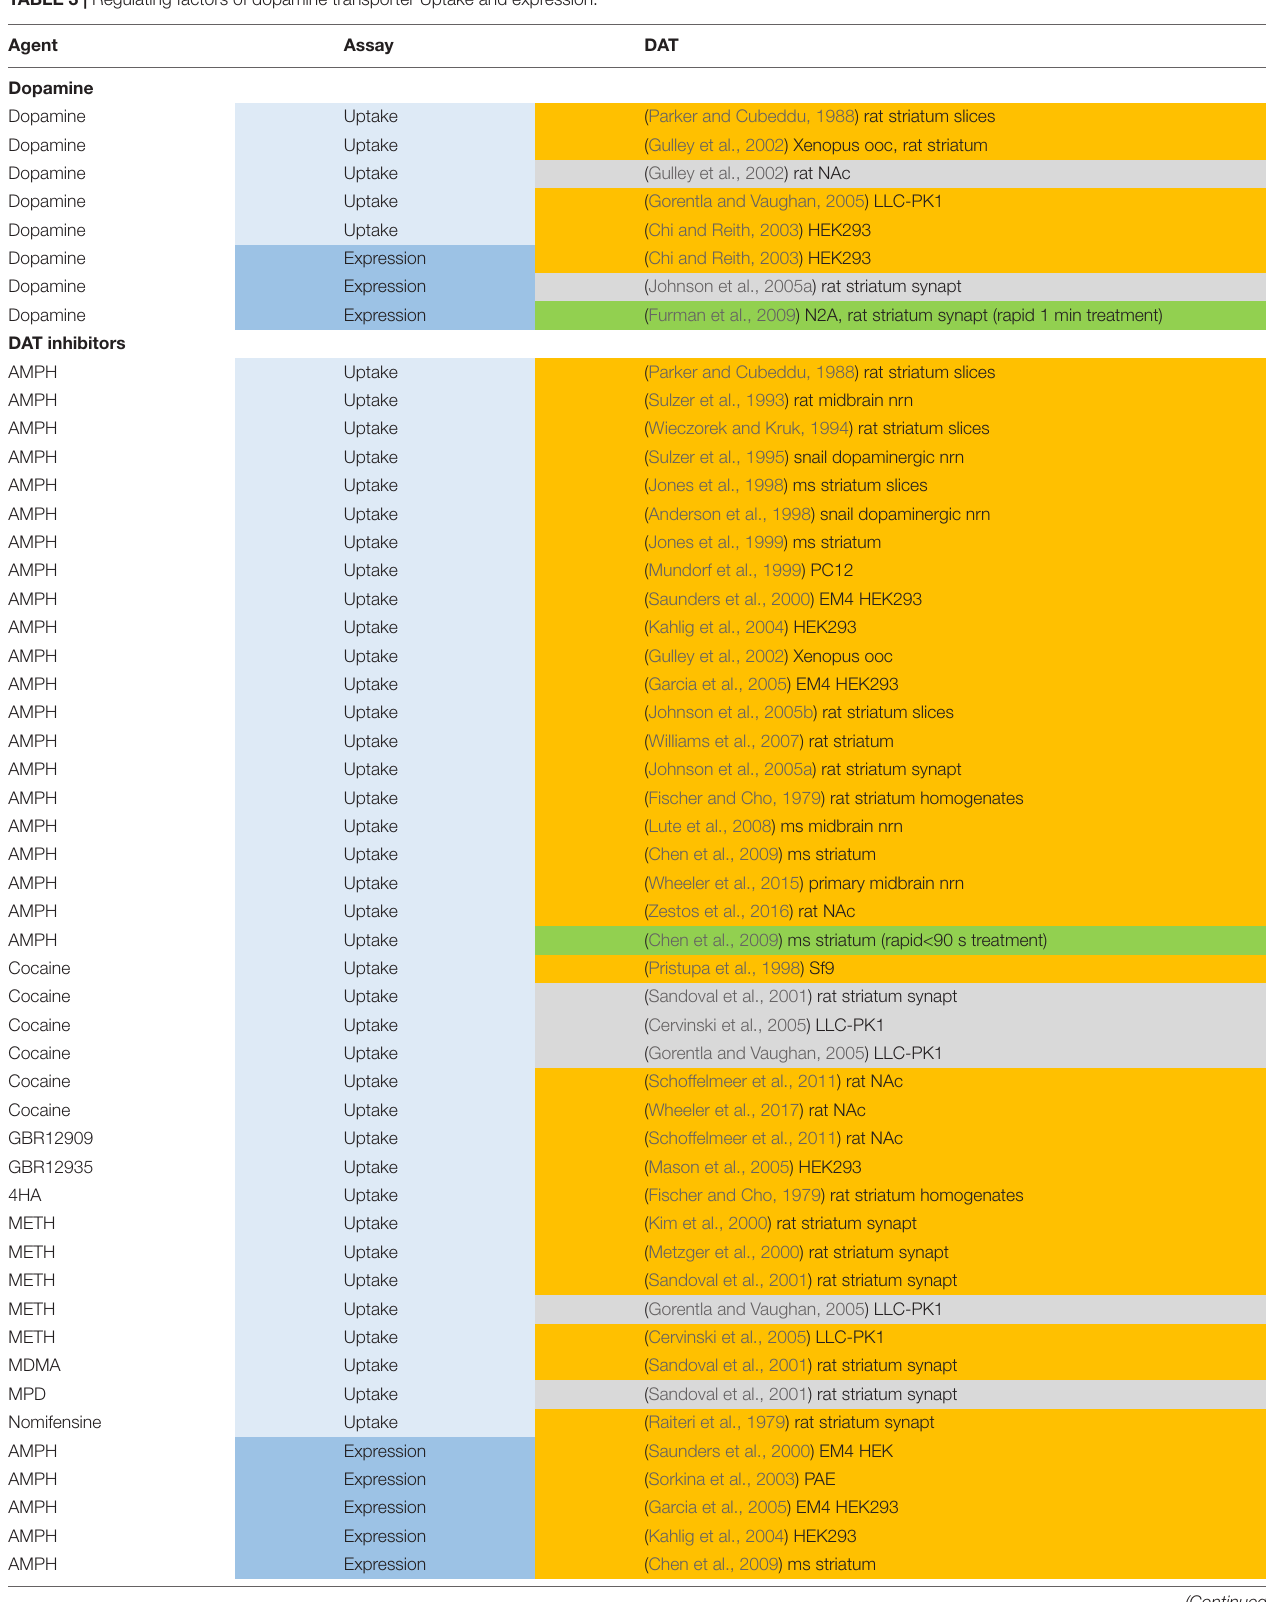
TABLE 3 | Regulating factors of dopamine transporter Uptake and expression. Agent Assay